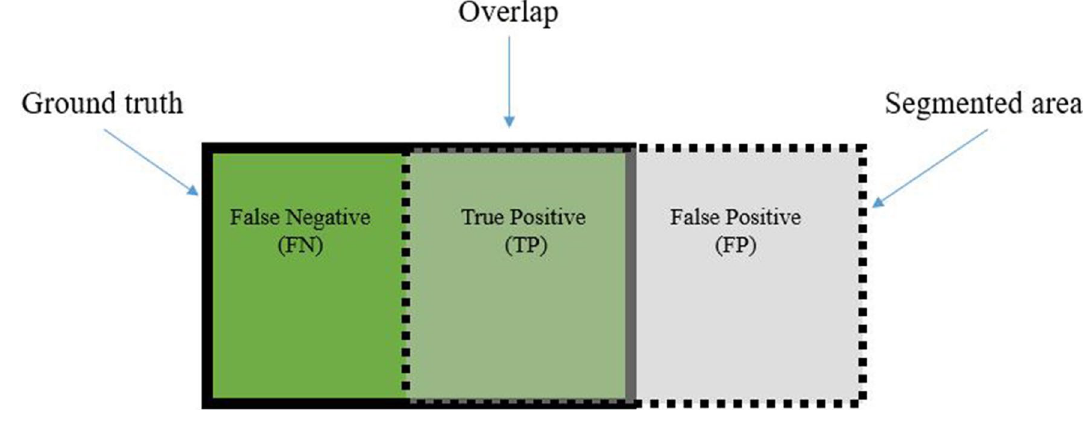
Figure 6. The graphic display of TP, FP, and FN for a segmentation problem.